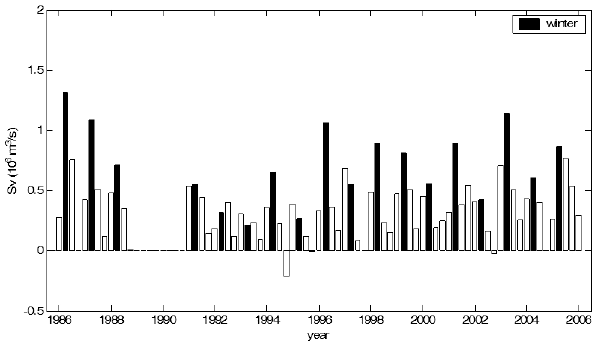
Fig. 3. Seasonal evolution of the transport in the Corsica Channel. Black bar indicates the winter transport. Fig. 11. Evolution of the transport through the Corsica Strait. Each 77 bar corresponds to a transport averaged over 3 months. Black bars indicate the winter transport while the white bars give the spring, summer and fall transports. From Gasparini et al. (2008).